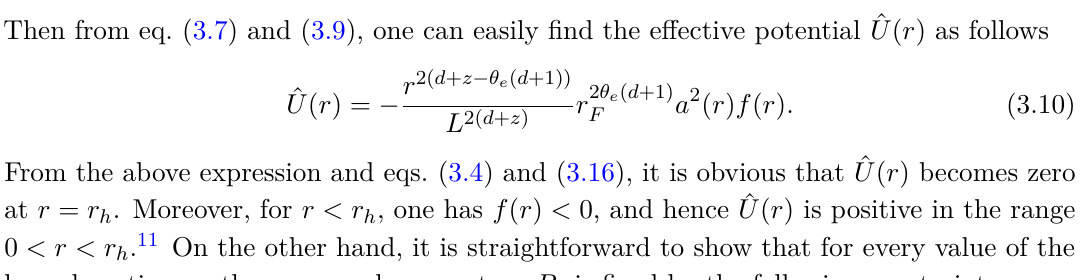
Figure 1 . The extremal codimension-one bulk hypersurface Σ( τ ) denoted in orange, starts from the left boundary at time t Next, it goes outside the horizon and reaches the right asymptotic boundary at time t consider symmetric hypersurfaces where t a constant-r hypersurface dubbed final slice at r = r curves are the radial cutoffs at r = r hypersurface anchored at t formation in section